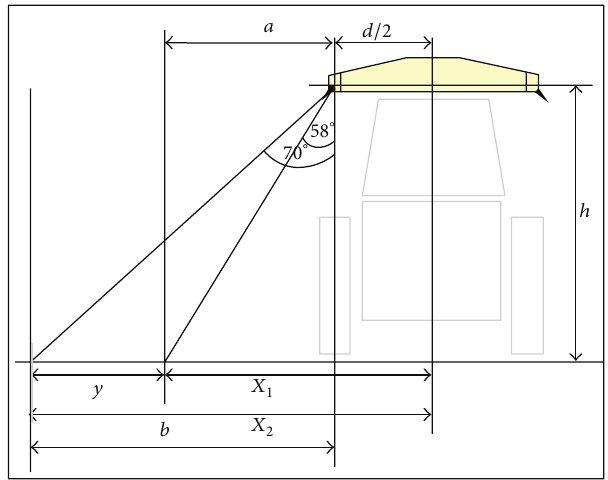
Figure 3: Front geometry of N-sensor mounted over the vehicle.